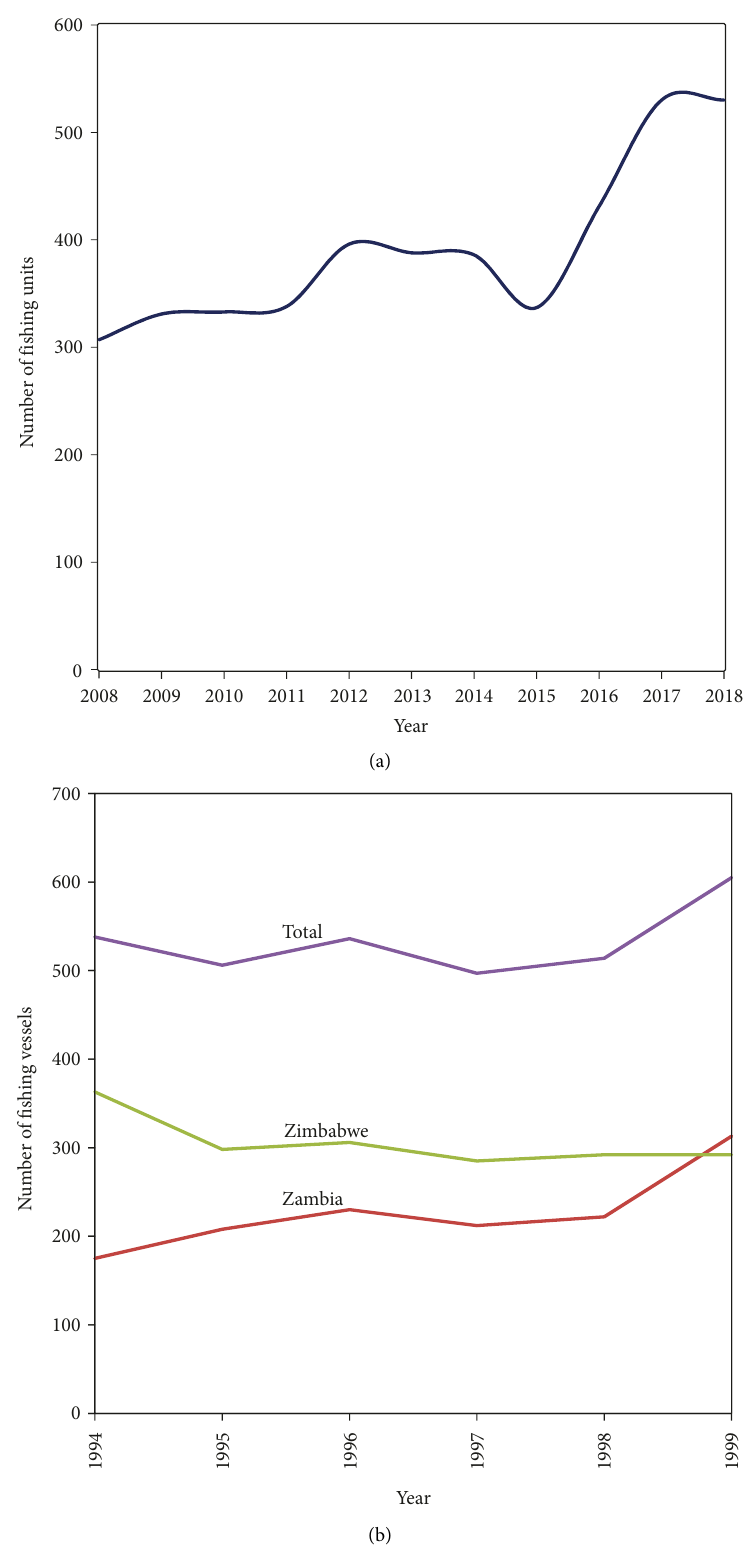
Figure 2: (a) Time series plot of fishing units from 2008 to 2018. (b) Time series plot of fishing units from 1994 to 1999